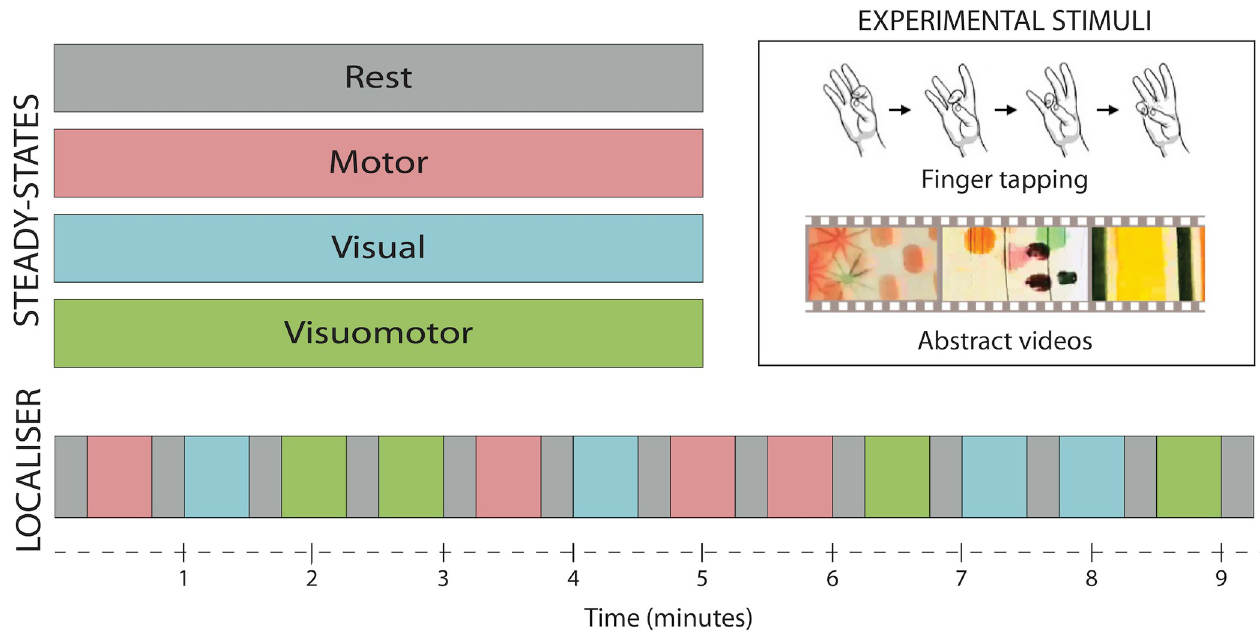
Fig 1. Steady-states design. Participants underwent a set of separate task-based (visual, motor and visuomotor) or task-free (resting) steady-state scans, each acquisition lasting five minutes. In addition, a task-localizer scan was employed to identify brain activations induced by each of the steady-state tasks.